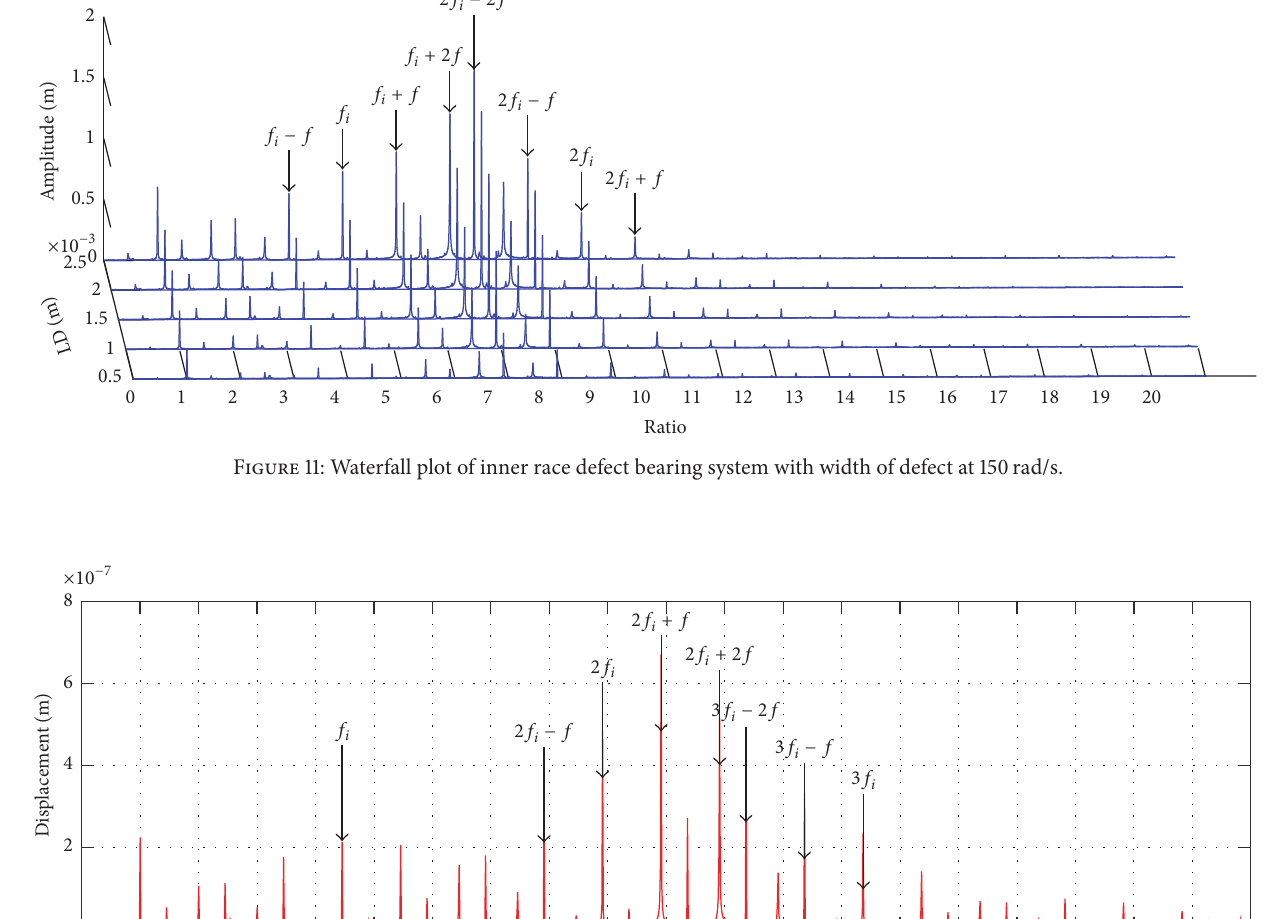
at a time. The spectral diagrams of the faulted system with the SFD mounted on the normal bearing at the speed of 100 rad/s, 150 rad/s are shown in Figures 12 and